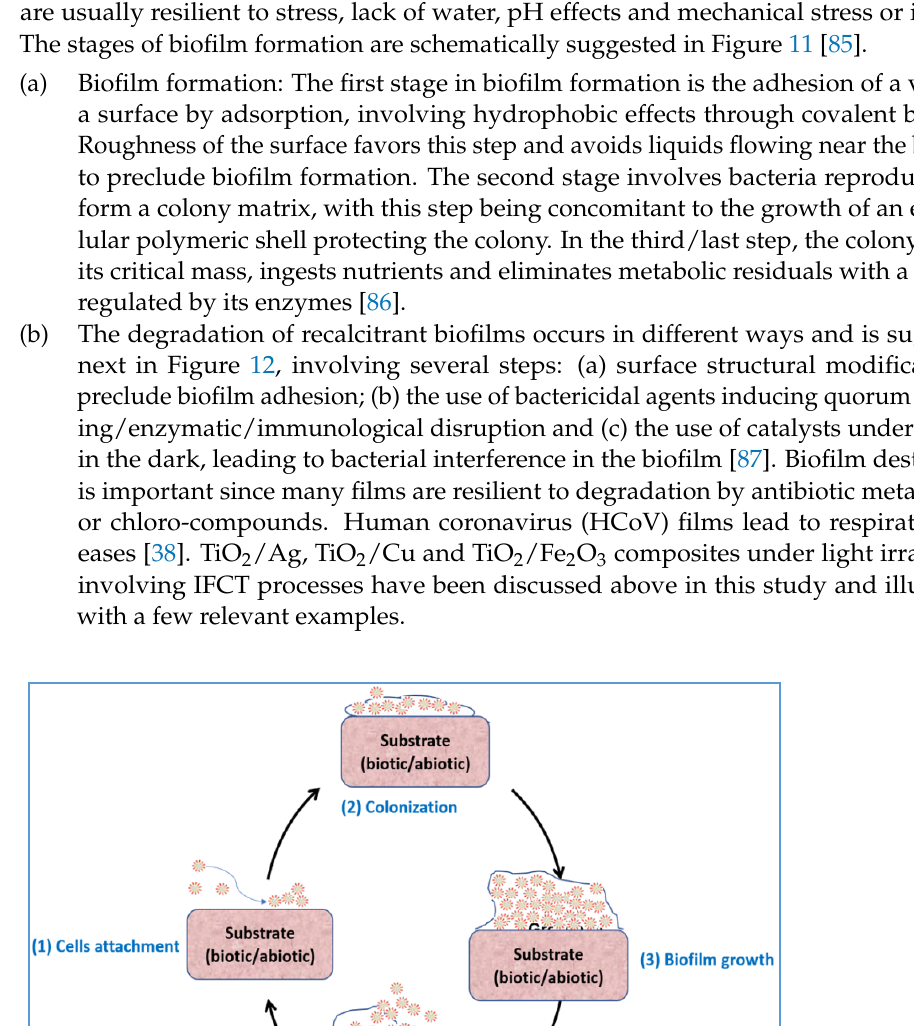
Figure 12. Strategies to neutralize the damage of toxic films spreading pathogens into the environ- ment.